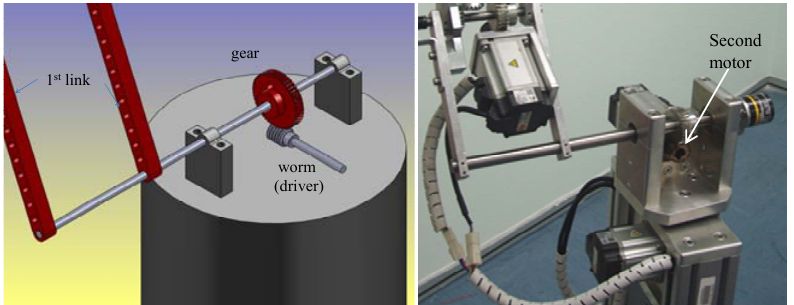
Figure 3. The design of the second joint angle (first link with second motor) of the manipulator [14]. The draft of the second joint angle using the SolidWorks software ( left ). The mechanical design of the second joint angle ( right ).